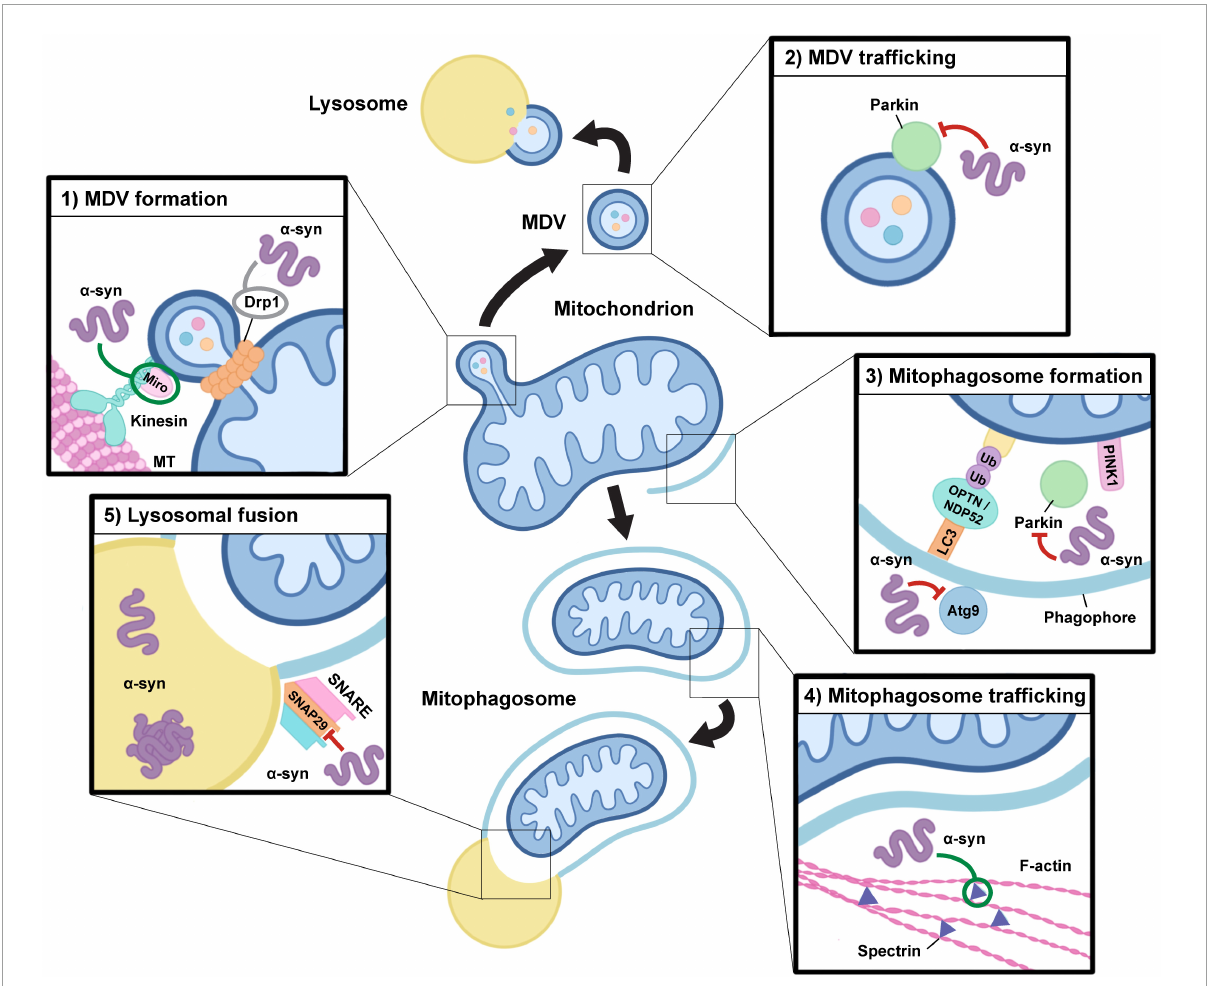
FIGURE2 Alterations in alpha-synuclein function may impact mitochondrial quality control pathways. Alpha-synuclein function and its aggregation may have an impact at multiple levels during both mitophagy and the mitochondrial-derived vesicle pathway. (1) MDV formation: Drp1 and Miro proteins are required for mitochondrial-derived vesicle (MDV) fission from the mitochondrion in response to local oxidative damage, which may be directly influenced by alterations in alpha-synuclein ( α -syn) function. Alpha-synuclein oligomers can stabilize Miro on the mitochondrial membrane and modulate Drp1 localization, although the precise impact of alpha-synuclein-induced alterations in Drp1 function is still a point of contention (indicated in gray). (2) MDV trafficking: Oligomeric species of alpha-synuclein may downregulate Parkin expression and alter its localization, which could have negative impacts on MDV formation and trafficking to the lysosome. (3) Mitophagosome formation: Mitophagy requires the action of PINK1 and Parkin to trigger the ubiquitylation of outer membrane proteins which leads to the recruitment of autophagy receptors, including NDP52 and OPTN, which facilitate the capture of damaged mitochondria within a phagophore, which matures into a mitophagosome. Alpha-synuclein may impact this process through alterations in Parkin activity and by inhibiting the recruitment of Atg9-positive vesicles which are required for autophagosomal membrane expansion. (4) Mitophagosome trafficking: Through interactions with spectrin, overexpression and accumulation of alpha-synuclein oligomers alters actin cytoskeletal dynamics resulting in its aberrant stabilization, which may negatively impact the maturation and trafficking of mitophagosomes required for endosomal and lysosomal fusion. (5) Lysosomal fusion: To enable cargo degradation, the mitophagosome requires the action of SNARE protein complexes to facilitate lysosomal fusion. Pathogenic overexpression of alpha-synuclein may alter SNAP29 activity, thus influencing the ability of mitophagosomes to fuse with lysosomes. In addition, accumulation of monomeric and oligomeric species of alpha-synuclein within lysosomes alters their activity, which may result in negative impacts on cargo degradation in both the mitophagy and MDV